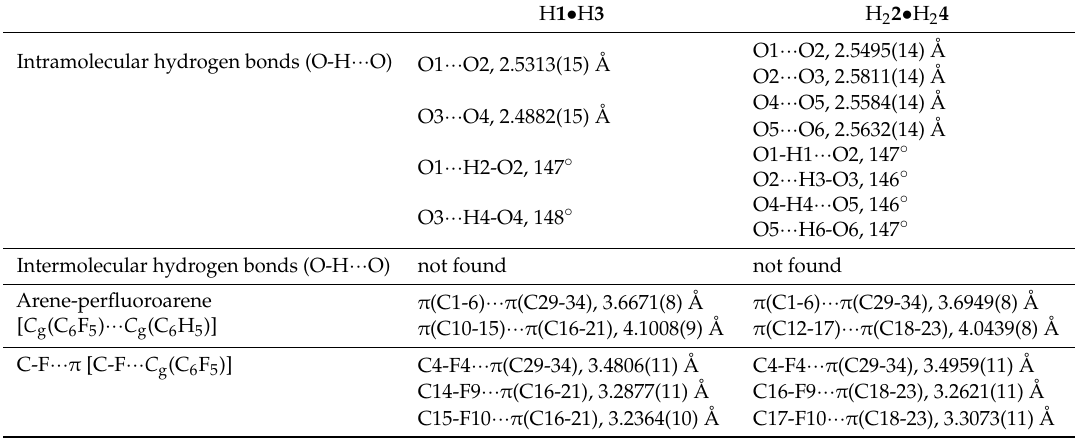
Table 2. Major intra- and intermolecular interactions of H 1 • H 3 and H 2 2 • H 2 4 .